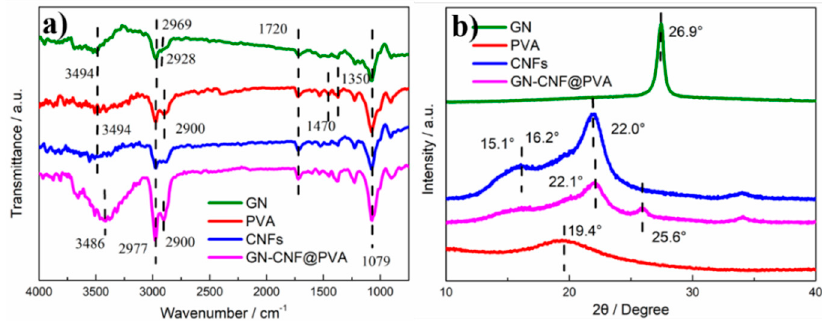
Figure 3. ( a ) Fourier transform infrared (FTIR) analysis and ( b ) X-ray diffraction (XRD) results of GN, CNFs, PVA hydrogel and GN-CNF@PVA hydrogel.